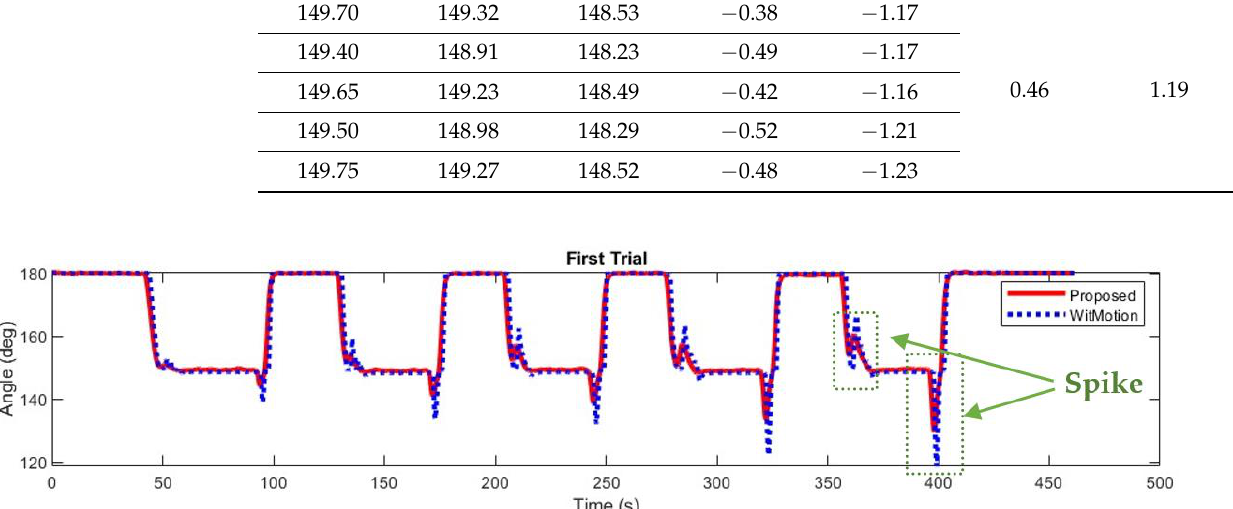
Figure 6. Measured angle using proposed algorithm (PA) and WitMotion (WM) (first trial). Figure 7. Measured angle using proposed algorithm (PA) and WitMotion (WM) (second trial).